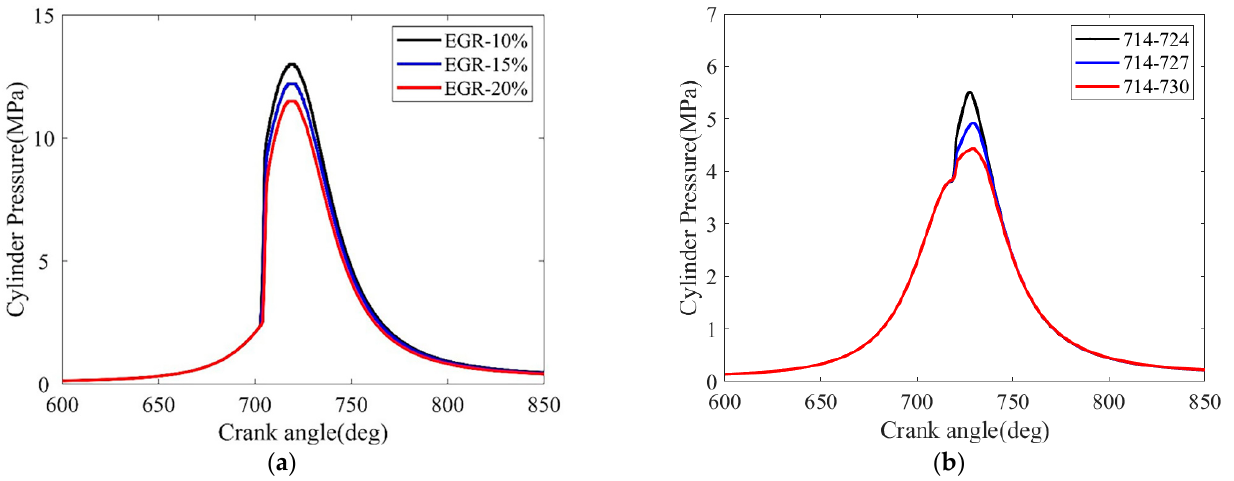
Figure 8. Cylinder pressure for different EGR rates and injection durations: ( a ) different EGR rates; ( b ) different injection